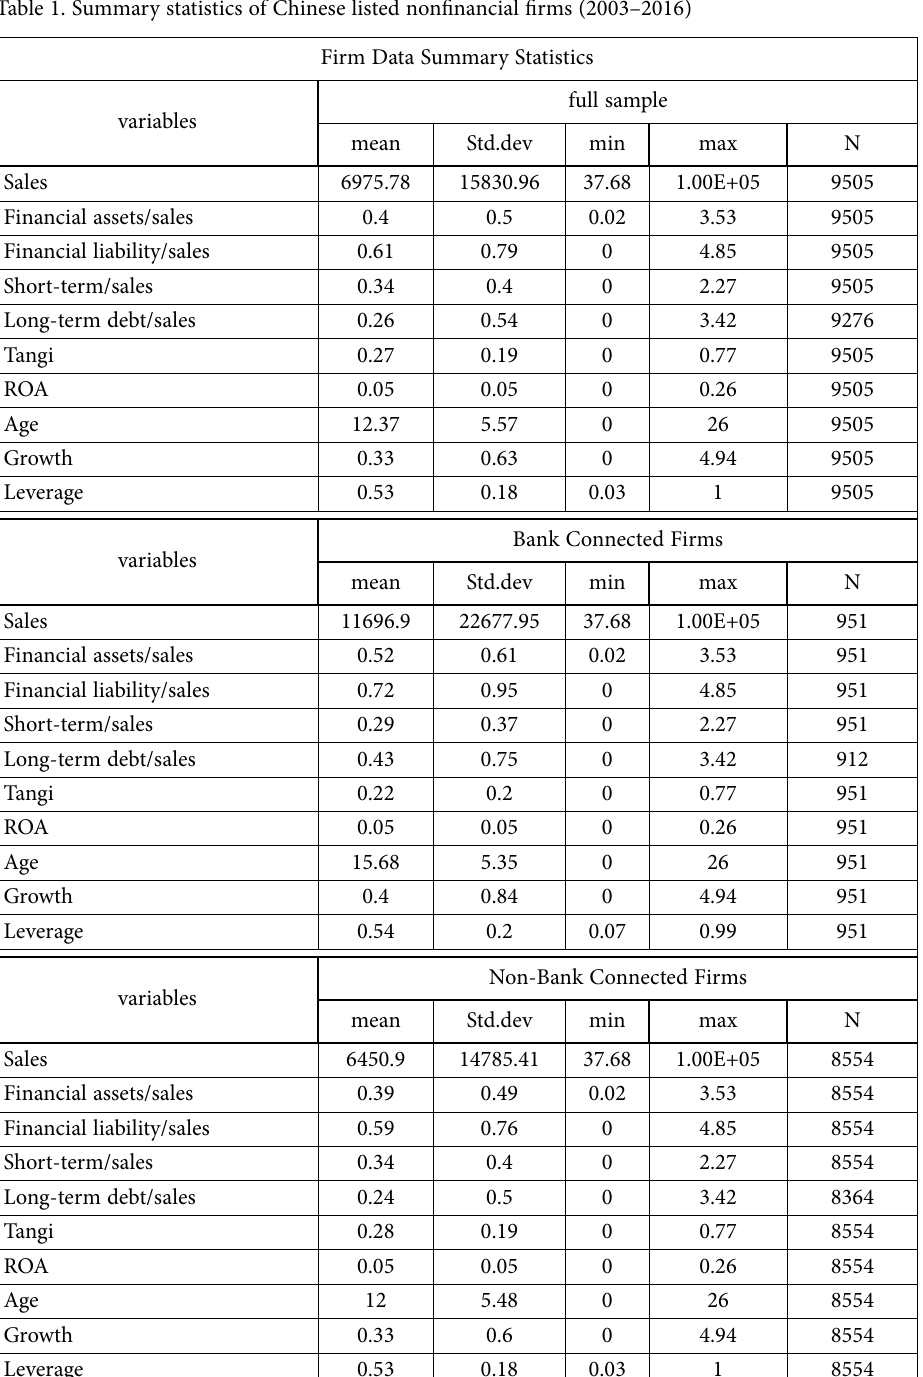
Table 1. Summary statistics of Chinese listed nonfinancial firms (2003–2016) Firm Data Summary